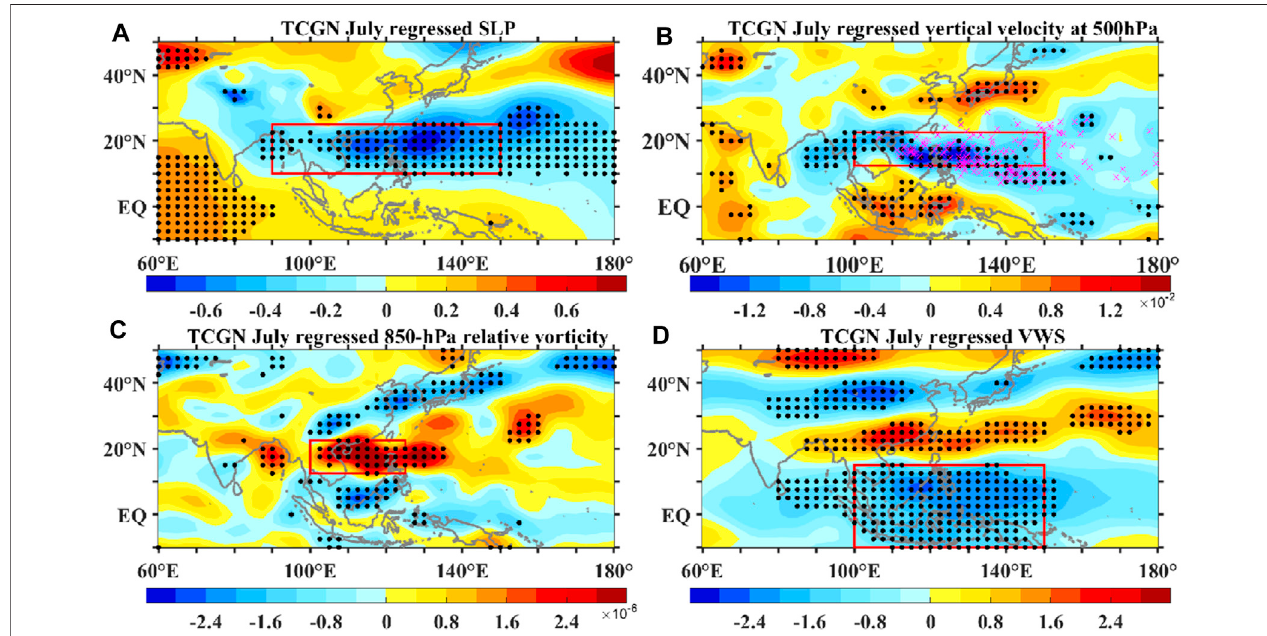
FIGURE 3 | Regression patterns of the July. (A) SLP anomaly (units: hPa), (B) 500-hPa vertical velocity anomaly (units: Pa/s), (C) 850-hPa relative vorticity anomaly (units: 10 – 6 s), and (D) VWS anomaly between 850 and 200 hPa (units: m/s) upon the standardized July TCGN during 1980 – 2020. Dotted areas indicate statistical signi fi cance at the 95% level, as estimated by a Student ’ s t -test. The regions marked by the red rectangle are used to de fi ne four atmospheric circulation indices.